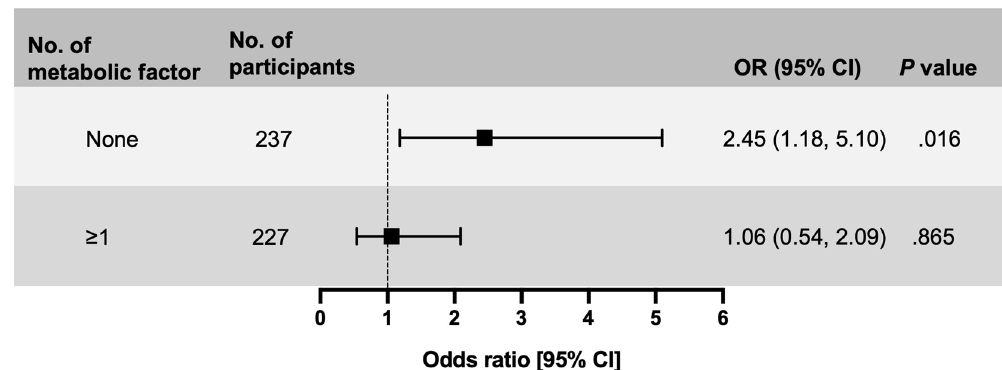
Figure 3. High-level FIB-4 score was a risk factor for incident chronic kidney disease after a 5-year follow-up, by the number of metabolic factors. Odds ratios (ORs) were calculated after propensity score matching. Metabolic factors included body mass index ≥ 25.0 kg/m 2 , hypertension (defined as systolic blood pressure ≥ 140 mmHg, diastolic blood pressure ≥ 90 mmHg, and/or the use of antihypertensive medication), or daily smoking